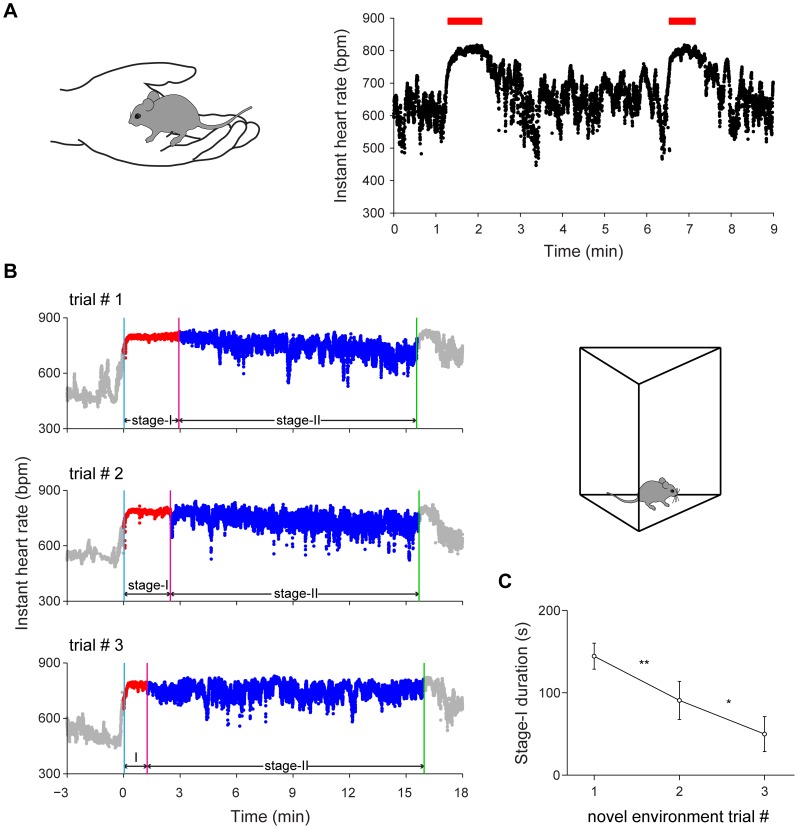
Instant heart rate responses to handling and novel environment exposures.(A) Illustration of the handling method: cup handling [38] (left) and two examples of instant HR response to handling (right). The red bars indicate the duration of handling (49 seconds and 37 seconds, respectively). (B) Instant HR responses of an individual mouse during repeated exposures to a novel environment (left panels) and illustration of a novel environment (right). The blue vertical line indicates the start of stage-I; the red vertical line indicates the end of stage-I; the green vertical line indicates the end of the novel environment exposure. (C) The duration of stage-I during repeated novel environment exposures. Error bars, s.e.m.; n = 7; *P<0.05, **P<0.01, one-way repeated measures ANOVA and Tukey post hoc test.